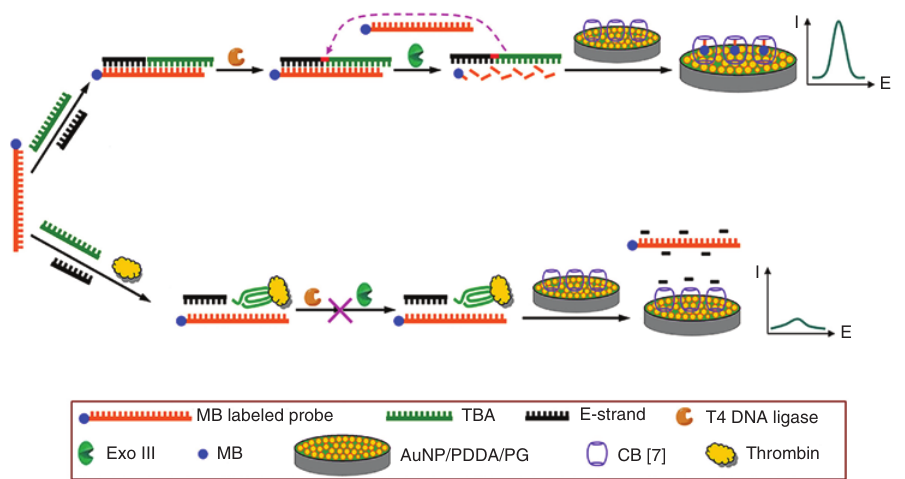
Figure 2: Schematic diagram for the preparation of the thrombin aptasensor based on ligase-assisted Exo III-catalyzed degradation reaction. CB [7],